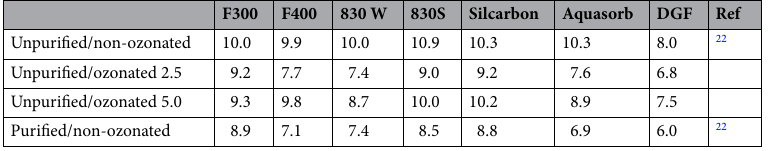
Table 1. Changes in pH pzc values due to purification and ozonation of activated carbons: unpurified non‑ ozonated, unpurified ozonated (pH 2.5 and 5) and purified non‑ozonated (E) [in